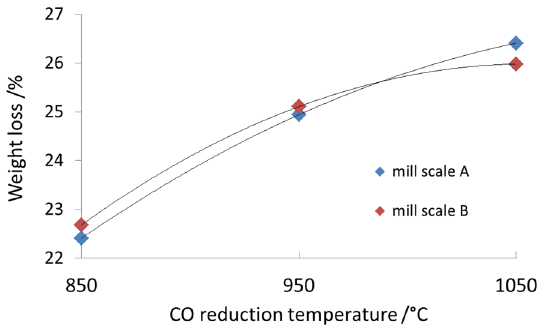
Figure 8. Average weight loss of studied mill scale during reduction with carbon monoxide at 850 ◦ C, 950 ◦ C and 1050 ◦ C—fractions A and B.